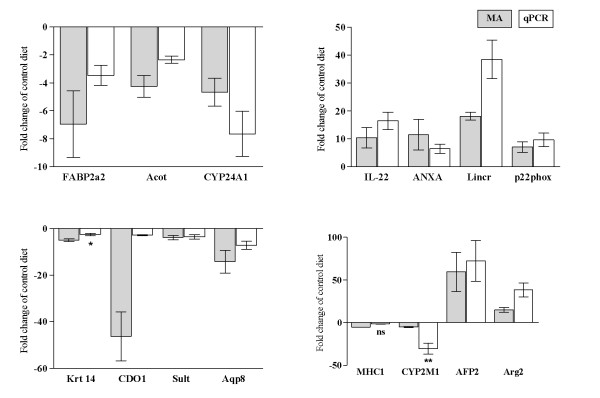
Comparison of qPCR and microarray (MA) results. Data are presented as fold changes of PCC control diet group. All MA results (n = 4 fish/group) are significant. For qPCR results (n = 9 fish/group), data differences between PPC and PPC + S group are denoted as * = p < 0.05, ** = p < 0.01 and ns = not significant. For genes not denoted, p < 0.0001. See Table 2 for acronym explanations.